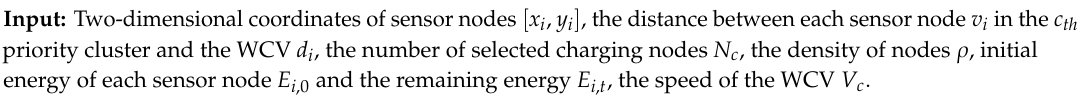
Algorithm 2. Procedure of solution for our